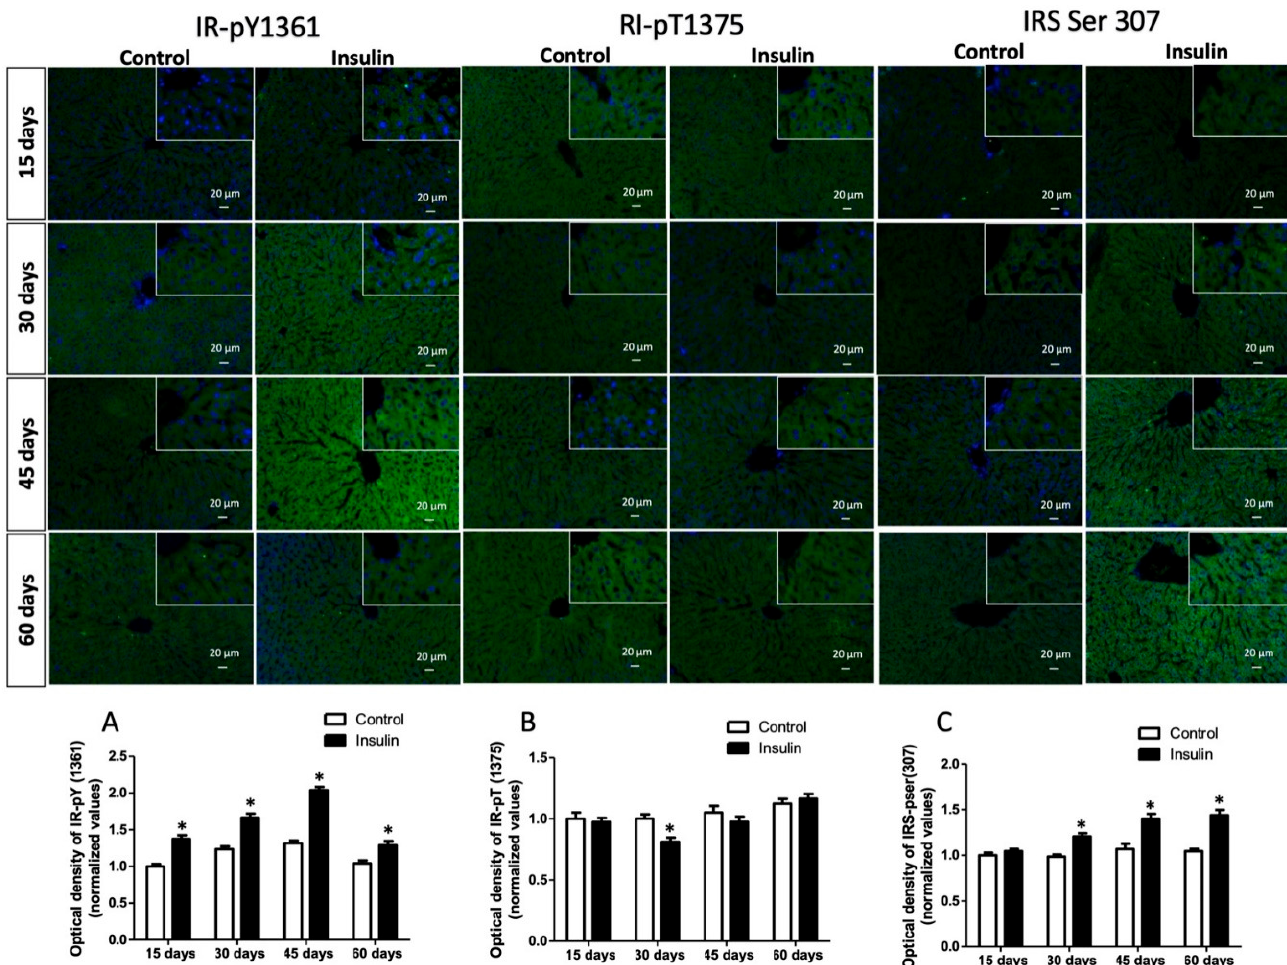
Figure 2. Evaluation of phosphorylation dynamic in the insulin receptor and IRS. ( A ) Tyrosine phosphorylation of insulin receptor (Y1361); ( B ) threonine phosphorylation of insulin receptor (T1375); ( C ) IRS serine phosphorylation of substrate insulin receptor (S307). Results are the mean average of 10 separate experimental animals per group ± SEM. (*) indicates a significant difference regarding control groups ( p ≤ 0.05 by Mann–Whitney U test). The scale bar corresponds to 20 µ m in a magnifi- cation of 400X.